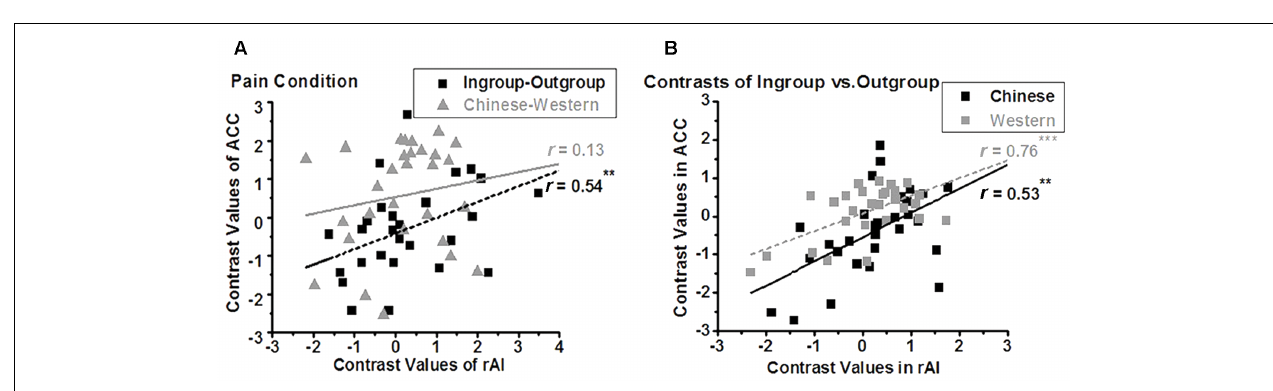
FIGURE 5 | Neural activity of the rAI is modulated by racial bias in nopain condition (A) , both for ingroup and outgroup (B) . In the nopain condition, a positive correlation is found between the contrasts of Chinese vs. Western (i.e., racial bias) of ACC and that of rAI ( A , triangle; ∗∗ adjusted p < 0.05), both for Ingroup and Outgroup members ( B , ∗ p < 0.05, ∗∗∗ p < 0.001, two tailed), but not between the contrasts of Ingroup vs. Outgroup (i.e., ingroup bias) of ACC and that of rAI ( A , rectangle).